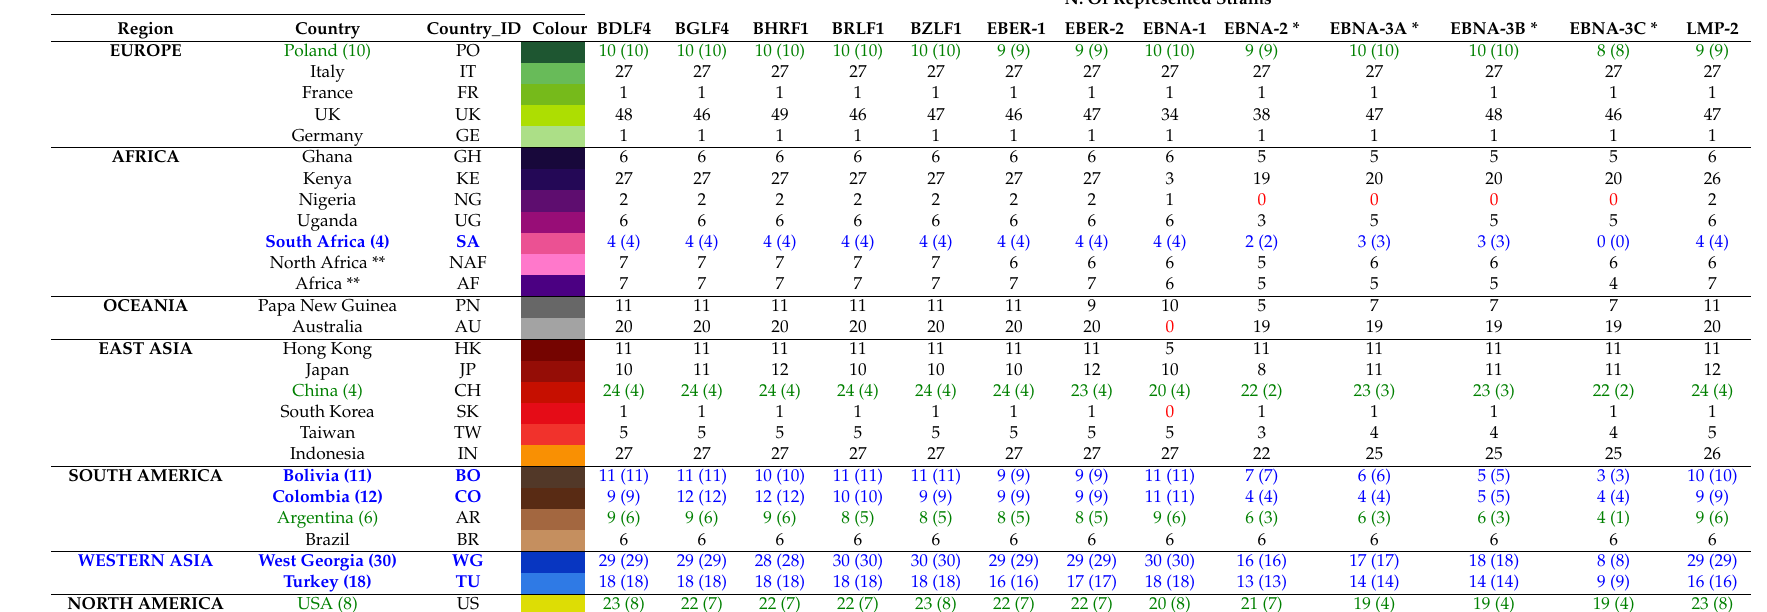
Table 1. Population of origin representation. The countries for which isolates were added for this study’s analyses are coloured in green, while newly described countries are in bold and coloured in blue. In red we highlight the gene / populations pair for which no isolate passed the quality filters. The number of added isolates is reported in parenthesis together with the country name. Values in the table represent, for each gene the number of isolates per country. * only type 1 isolates. ** = Annotations do not specify country of